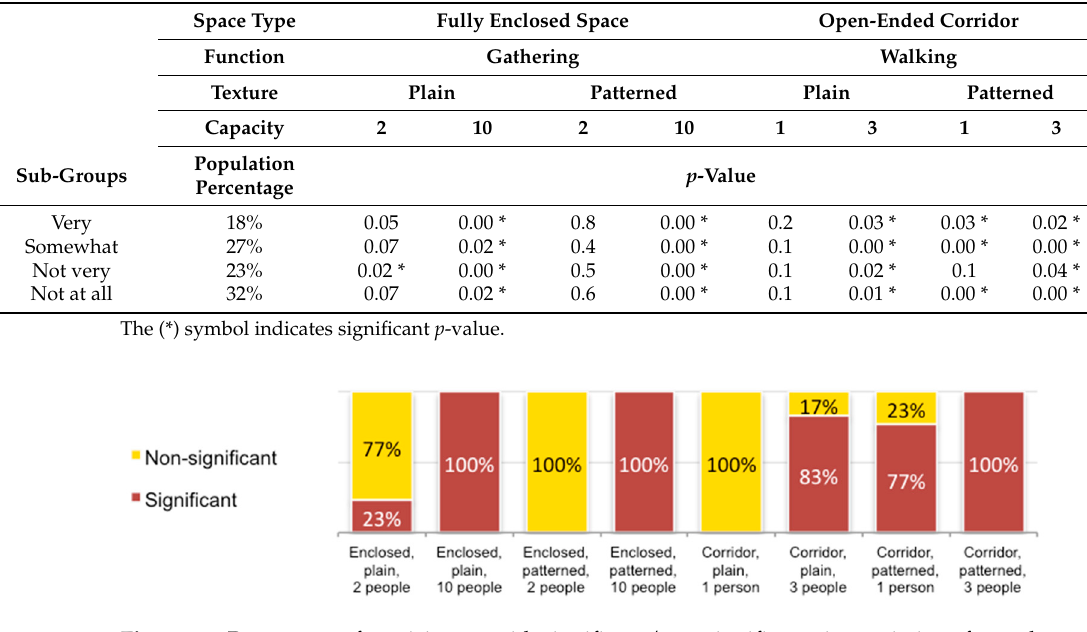
Figure 11. Percentage of participants with significant/non-significant size variations for each space in the familiarity with 3D immersive Virtual Reality environments perception